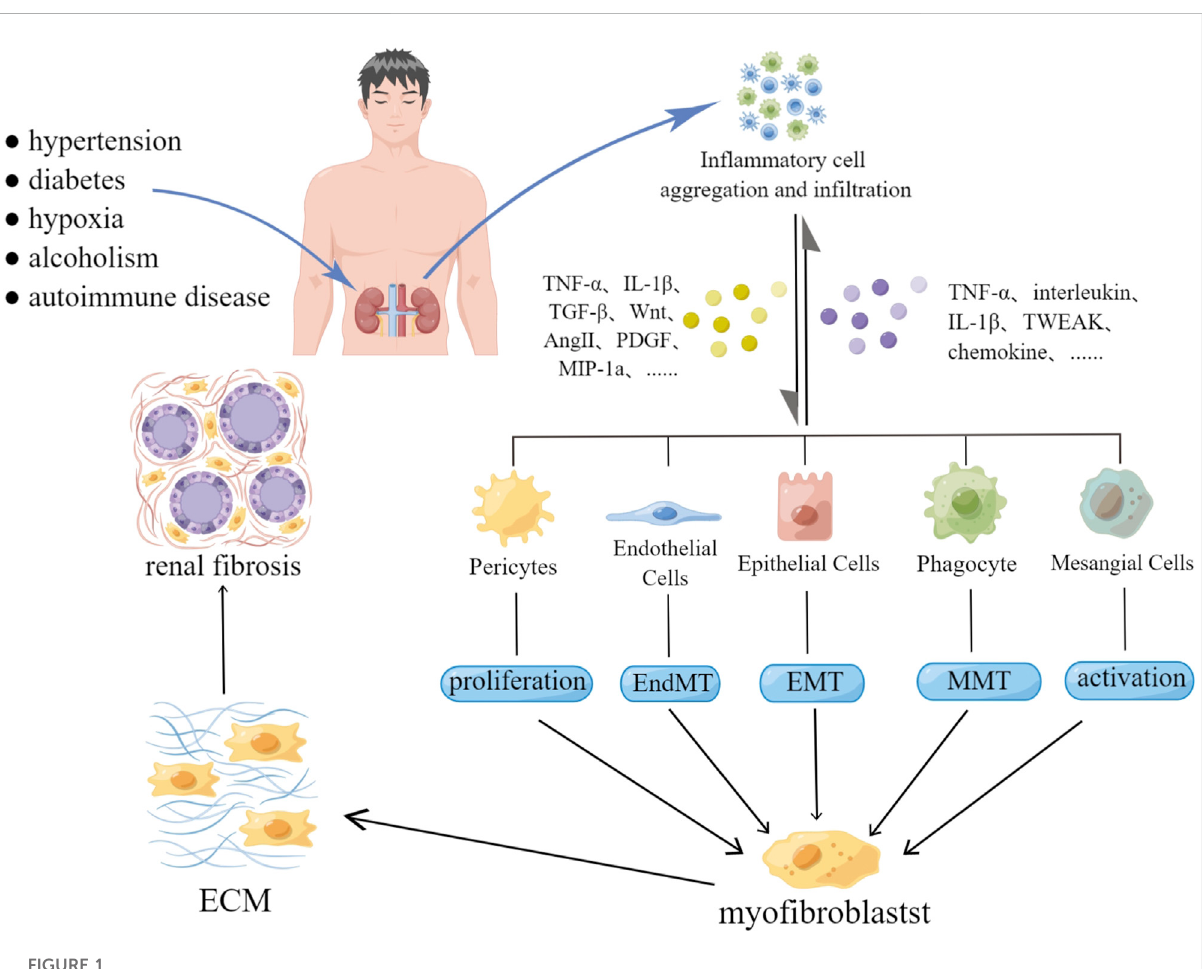
FIGURE 1 In fl ammation and renal fi